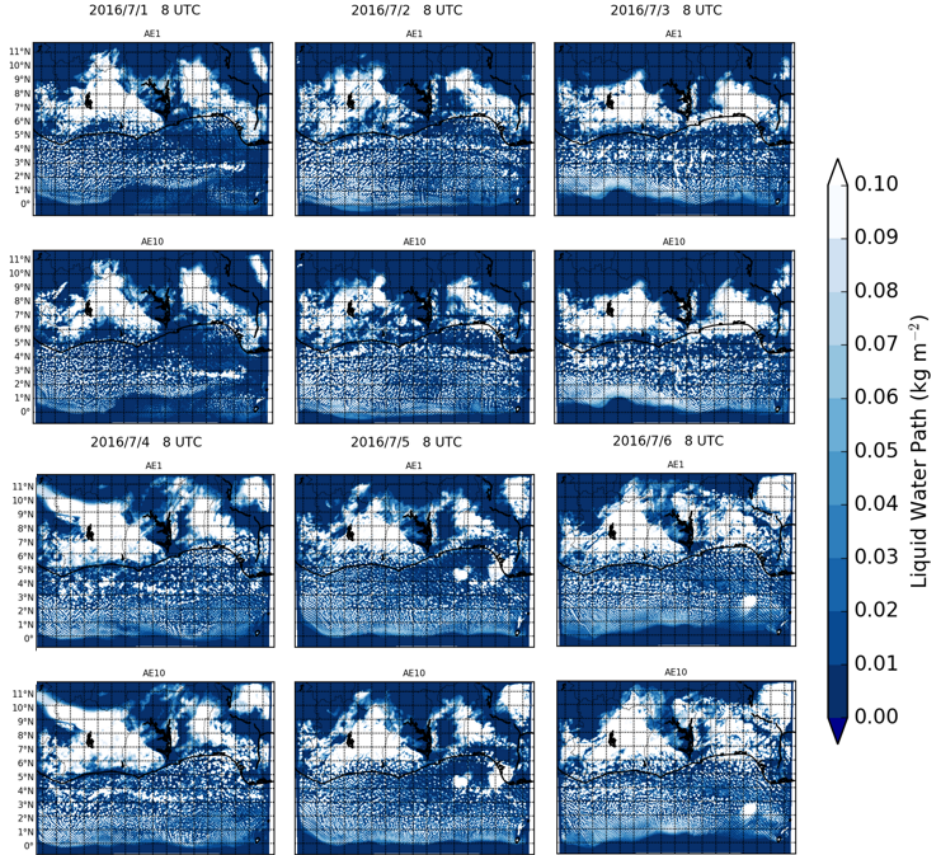
Figure A5. Modeled Liquid Water Path over the studied domain at 08:00UTC for the period 1–6 July 2016.